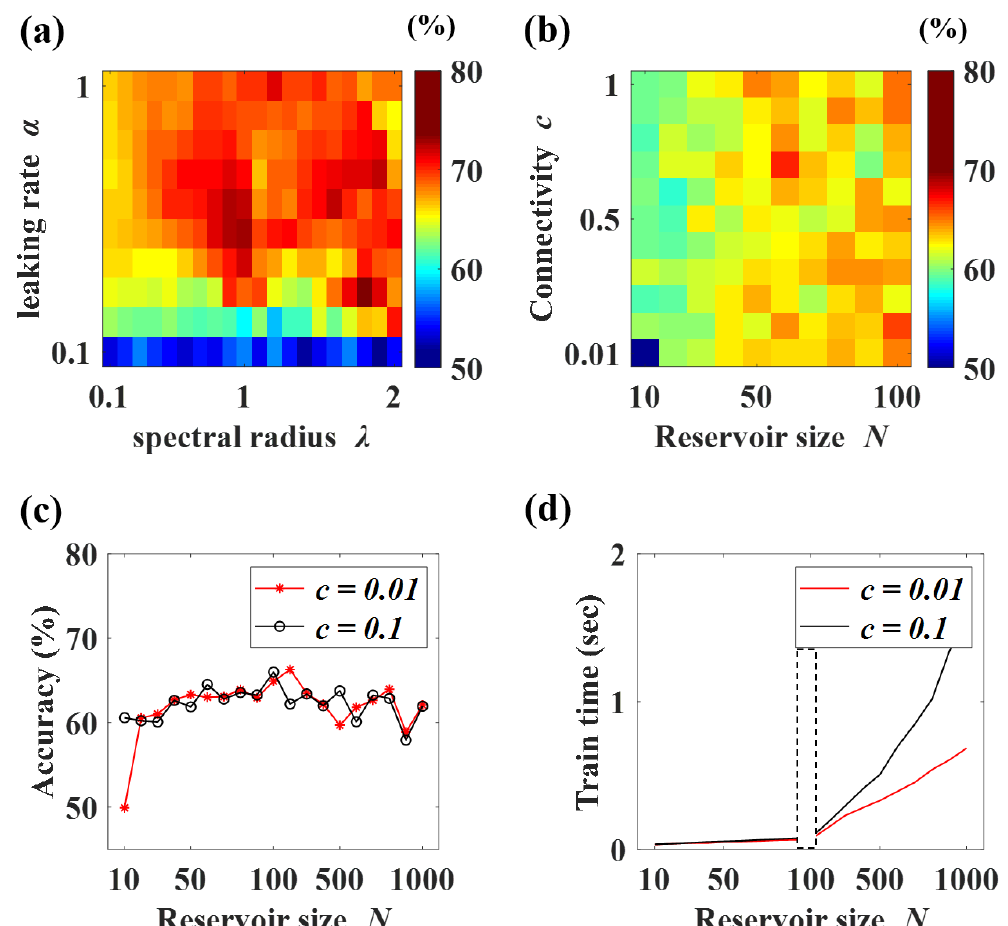
Figure A2. The influences of the parameters in the echo state network (ESN) in the 10-fold cross-validation. ( a ) The average accuracy according to spectral radius λ and leaking rate α . ( b ) The average accuracy according to the number of internal units ( N = 10, 20, ... , 100) and interconnectivity ( c = 0.1, 0.2, ... , 1). ( c ) Accuracy according to the number of internal units ( N = 100, 200, ... , 1000) with sparse interconnectivity ( c = 0.1, 0.01). ( d ) The computational cost of the training ESN according to the number of internal units. The computational cost linearly increased as the size increased. The sparser reservoir ( c = 0.01) had less computational cost compared with the denser reservoir ( c = 0.1), which became more evident as the reservoir size increased. The dotted box was inserted when the reservoir size was 100 because the N increases in steps of 10 between 10 and 100, and in steps of 100 between 100 and 1000.